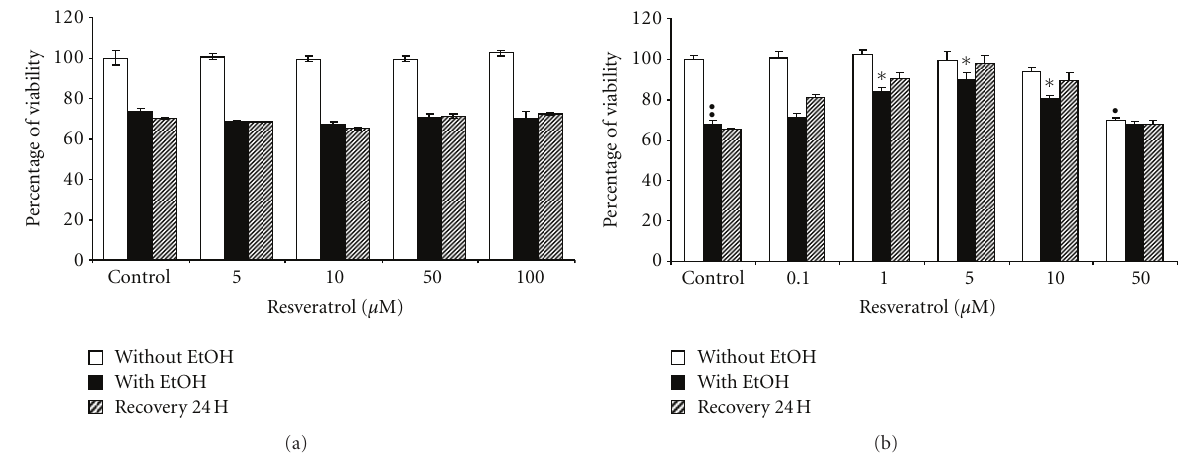
Figure 2: Astrocyte variation in viability after 1h of pretreatment with various concentrations of cis -resveratrol (a) or trans -resveratrol (b) followed by a 3-day exposure to 20mM ethanol in presence of resveratrol. Determinations were made directly after the exposure or after 24 h of recovery in fresh culture medium. Cytotoxicity was determined by MTT assay, and control without resveratrol and ethanol represents 100% viability. Data shown were obtained in a typical experiment representative of three independent experiments and are expressed as mean ± SEM, n = 5 ( • P < 0 . 01 resveratrol-treated cells versus control, •• P < 0 . 001 ethanol exposed cells versus control, ∗ P < 0 . 05, Res + ethanol treated cells versus control ethanol, Mann-Whitney U test). Cell exposure conditions are detailed in Section 2.